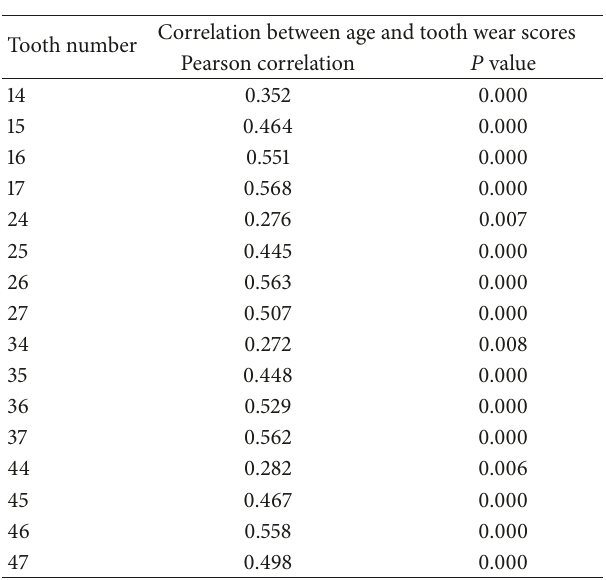
Table 6: Correlation between actual age and tooth wear scores by Karl Pearson’s correlation.